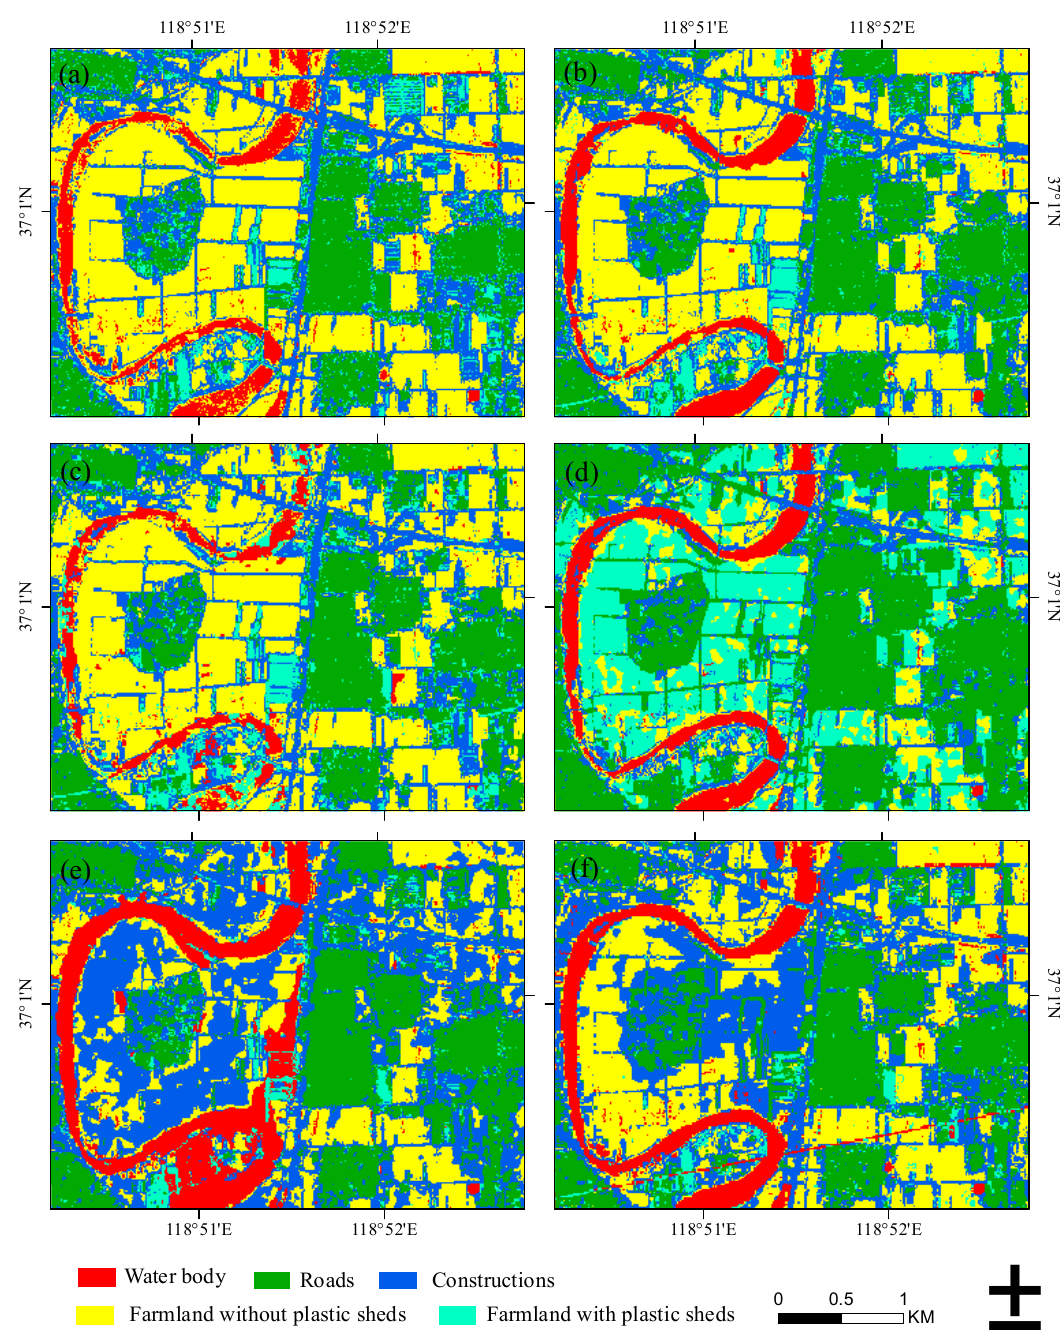
Figure 4. The normal optical classification using Sentinel-2 images and the random forest classification using S_Gamma bands and normal optical classification. ( a ) Random forest classification result based on Sentinel-2 on 10 August 2018; ( b ) Random forest classification result on 2 August 2018; ( c ) Random forest classification result on 21 July 2018; ( d ) Random forest classification result on 27 July 2018; ( e ) Random forest classification result on 20 August 2018; and ( f ) Random forest classification result on 26 August 2018.